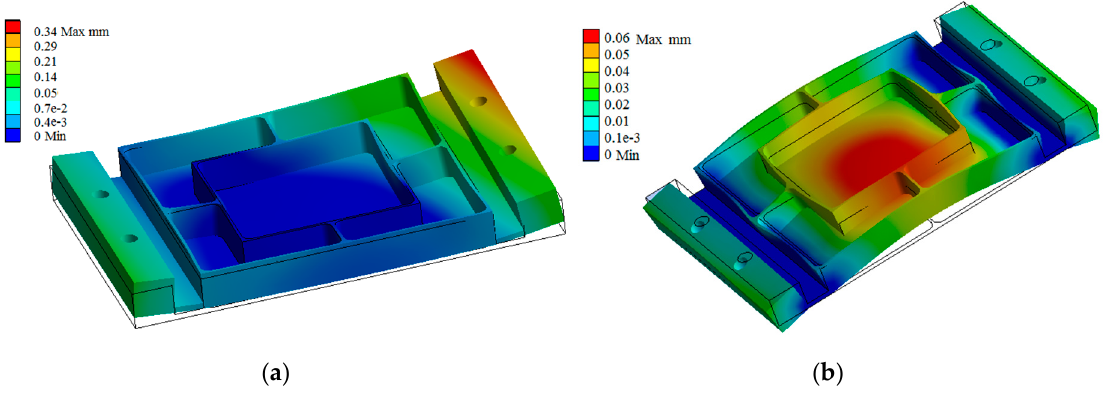
Figure 5. Measured deformation results of ( a ) Specimen 1 and ( b ) Specimen 2 obtained using ANSYS.